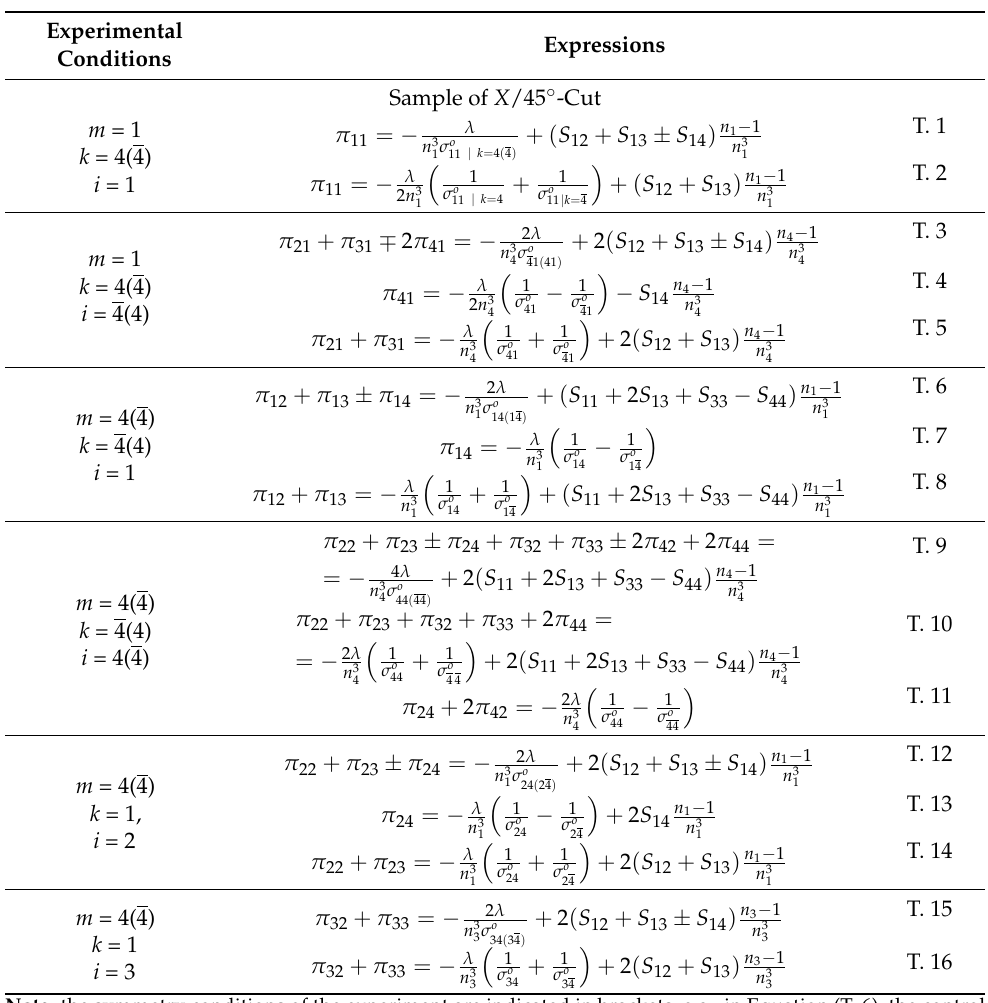
Table 1. The expressions for the determination of POCs π im on the sample of X /45 ◦ -cut for crystal classes 32, 3 m and 3 m given for the method of half-wave (control)